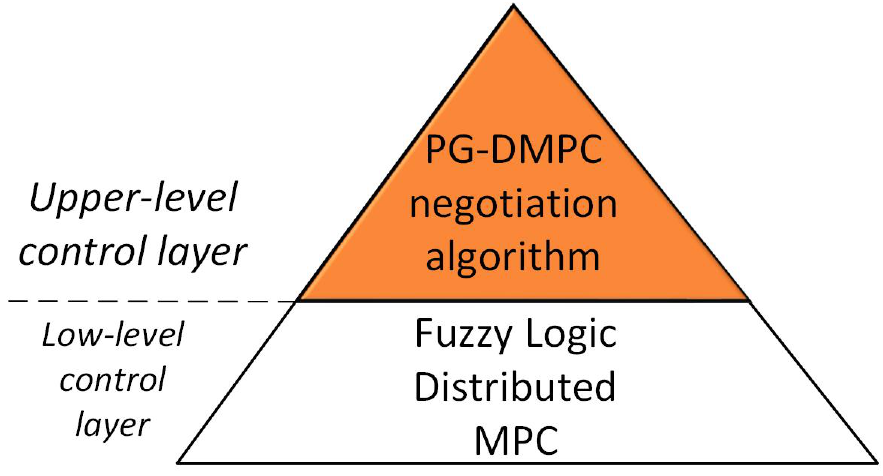
Figure 1. PG-DMPC algorithm proposed in the upper-level PG negotiation control layer within the control